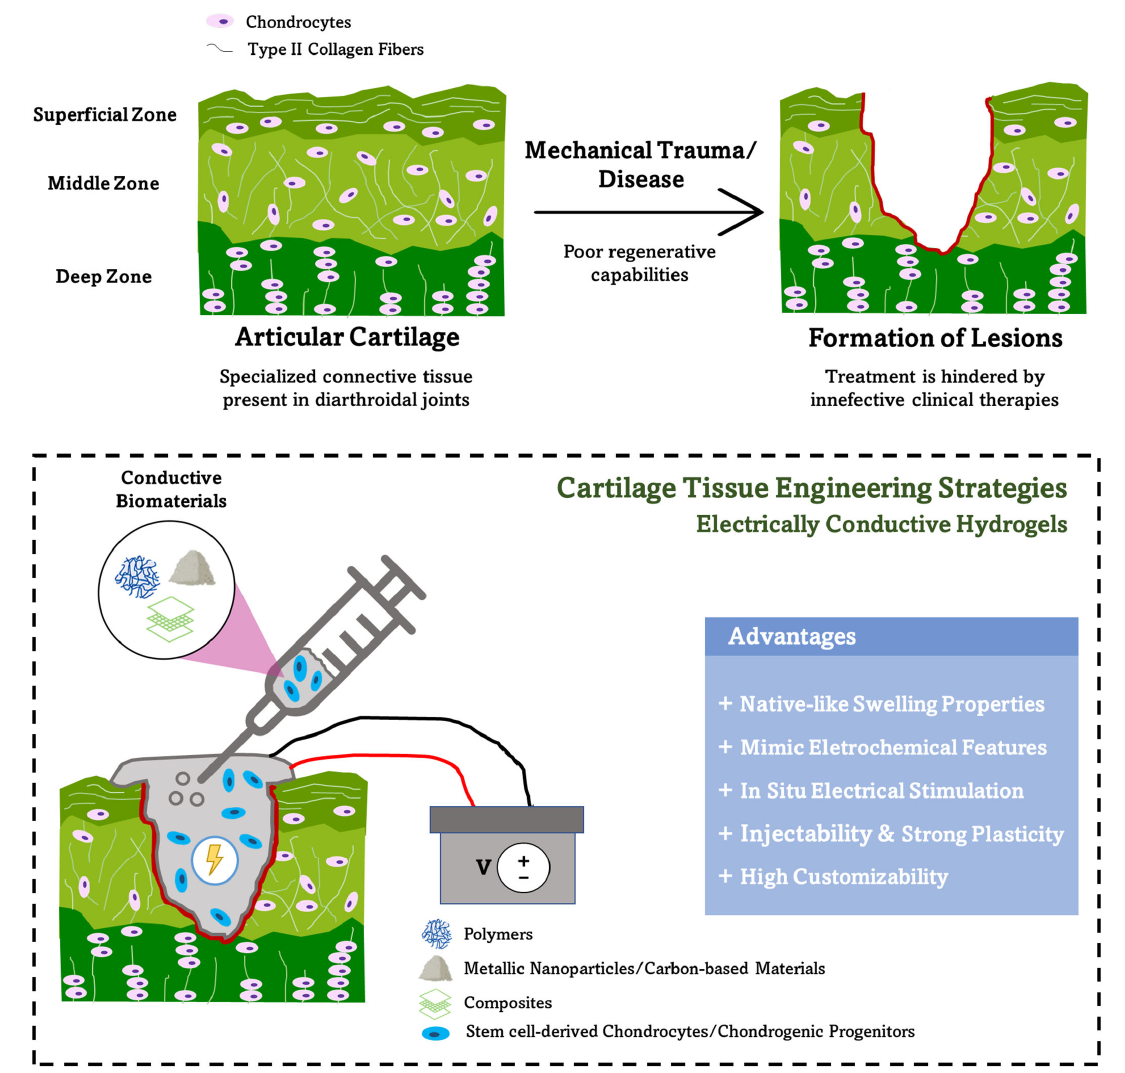
Figure 1. Electrically conductive hydrogels as a promising tool for the repair of articular cartilage defects caused by trauma or debilitating diseases such as osteoarthritis (top). These functional conductive hydrogels present several advantages for cartilage tissue engineering strategies (bot ‐